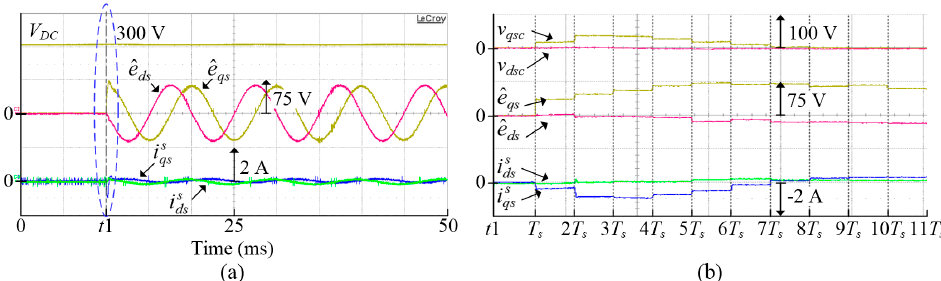
Figure 13. ( a ) Current responses when the back-EMF was decoupled but the initial controller voltage was set to zero (the motor speed was regulated at 3000 rpm by the load motor); ( b ) Amplified waveforms around t 1 .